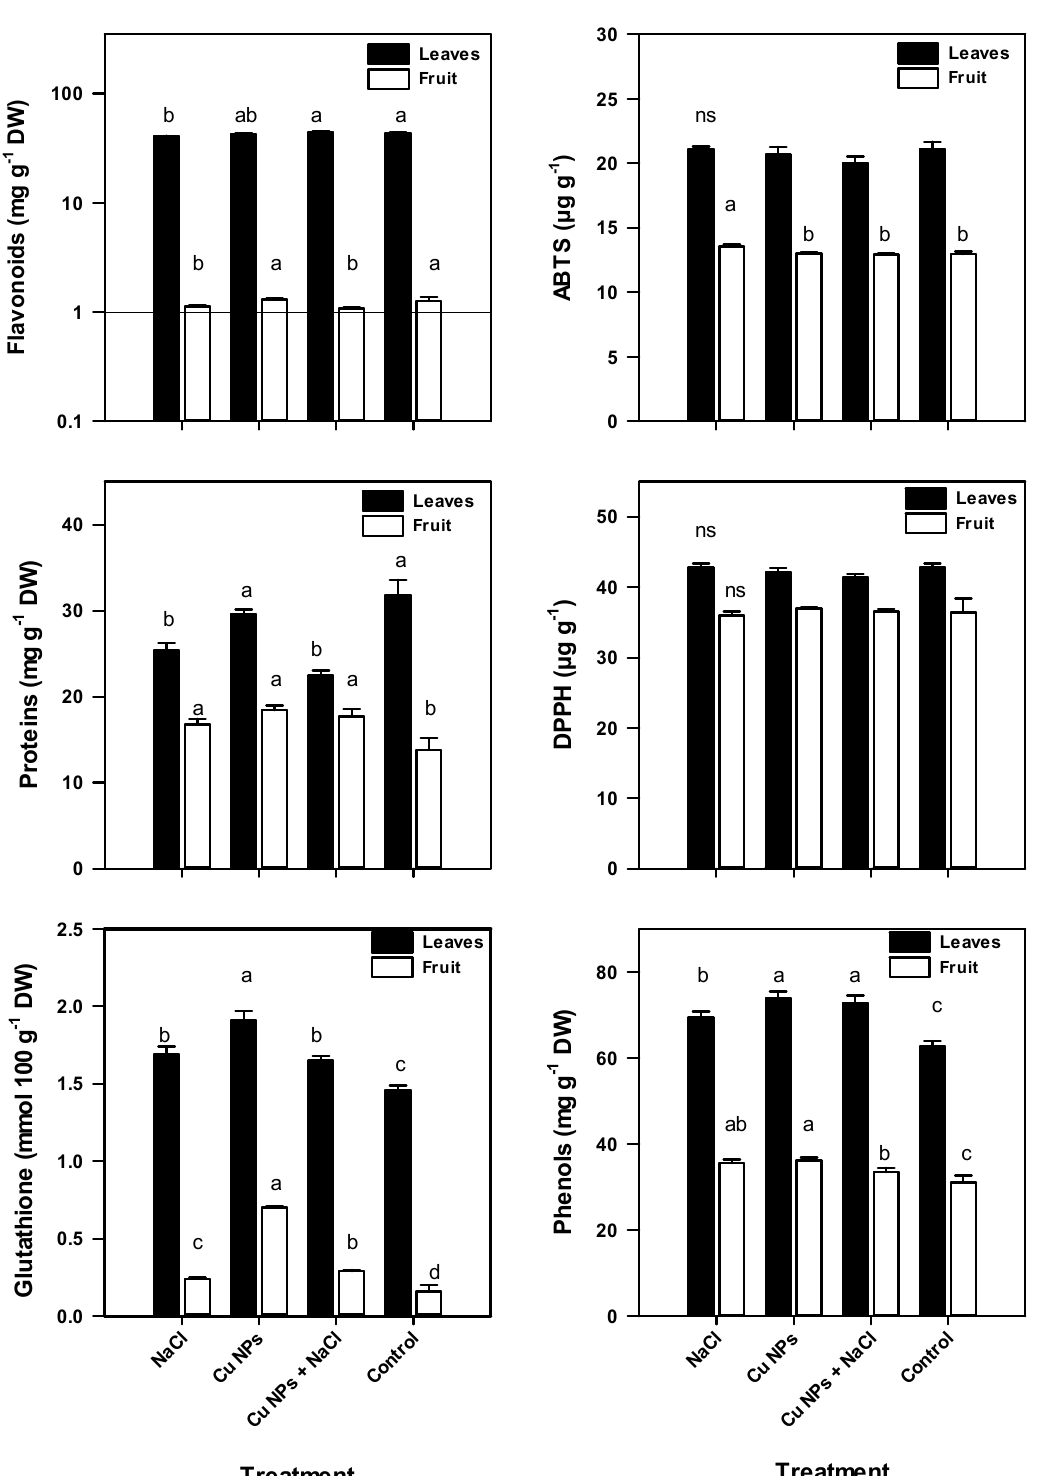
Figure 3. Proteins and antioxidant compounds in the leaves and fruits of tomato plants under saline stress and treated with foliar application of Cu NPs. All data are the mean of six replicates ± standard error. Different letters indicate significant differences between treatments according to Fisher’s Least Significant Difference ( p ≤ 0.05); ns—not significant.